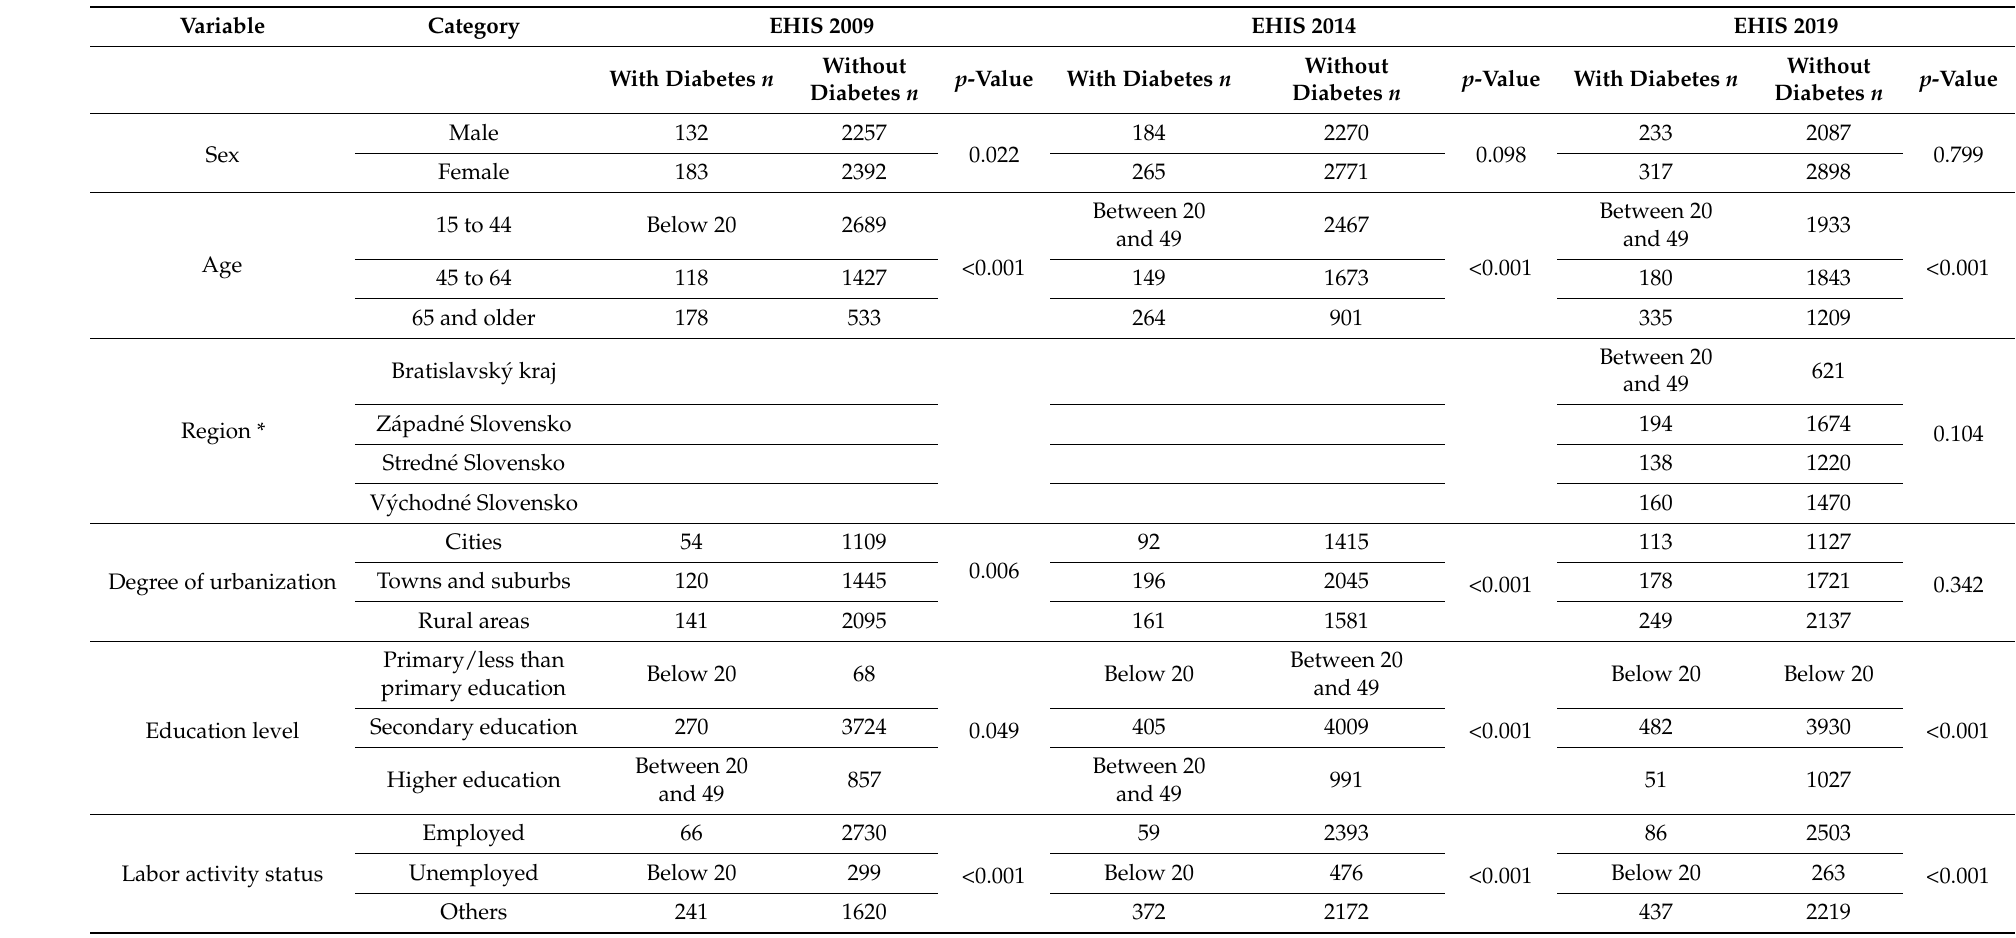
Table 1. Distribution of the study